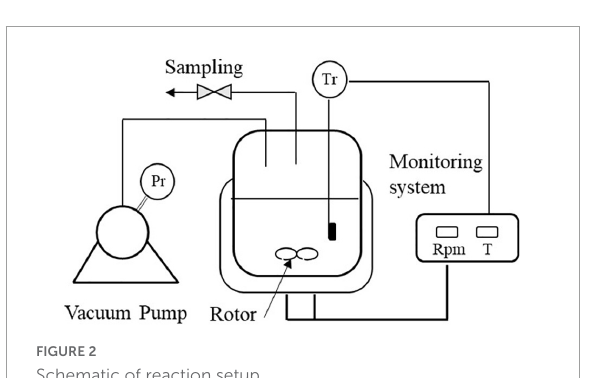
FIGURE2 Schematic of reaction setup.